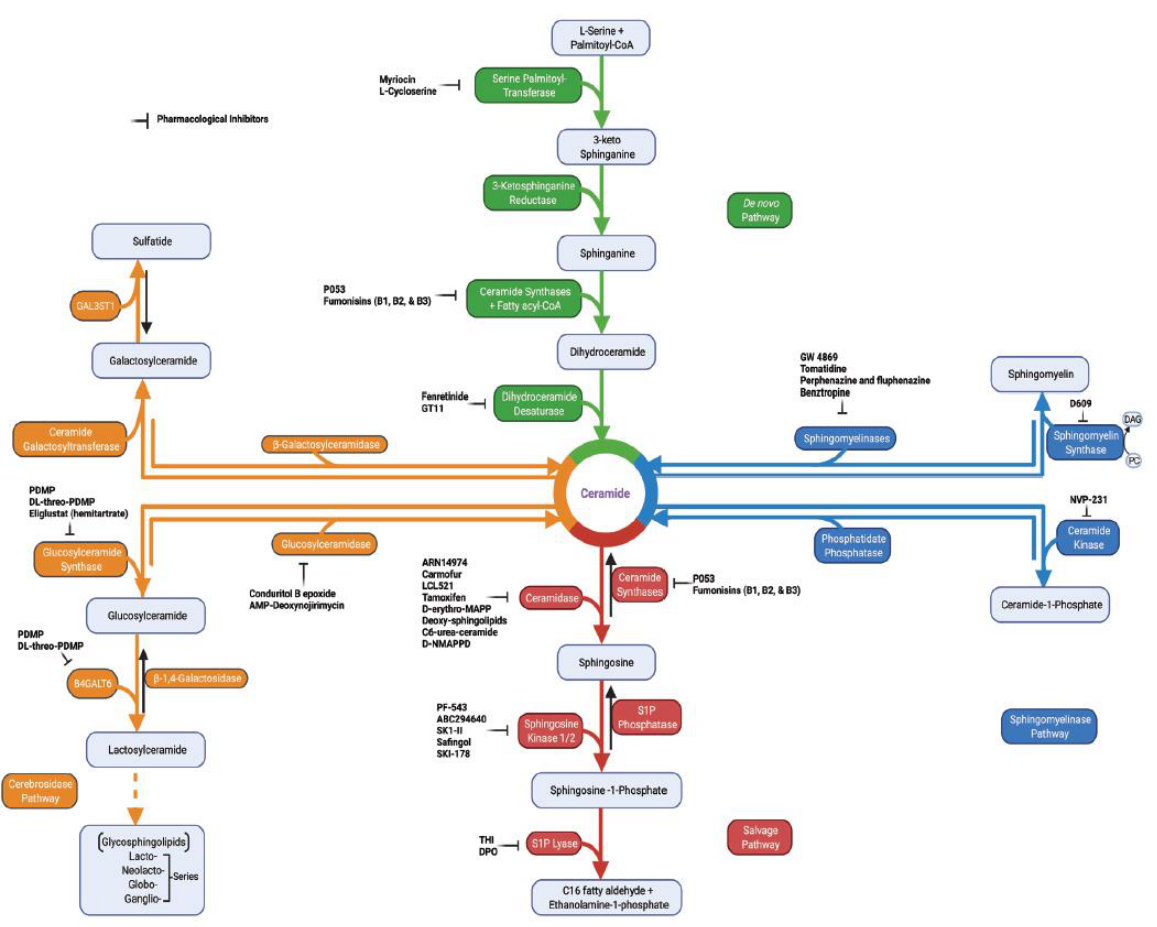
Figure 1. Sphingolipid metabolic pathways with selected inhibitors targeting enzymes. Ceramide, which is the intermediate molecule in sphingolipid metabolic pathway, can be formed either through de novo synthesis (green), sphingomyelin hydrolysis (blue), cerebrosides (orange), or salvage pathway (red). De novo synthesis starts with the functions of serine palmitoyltransferase (generates 3-keto